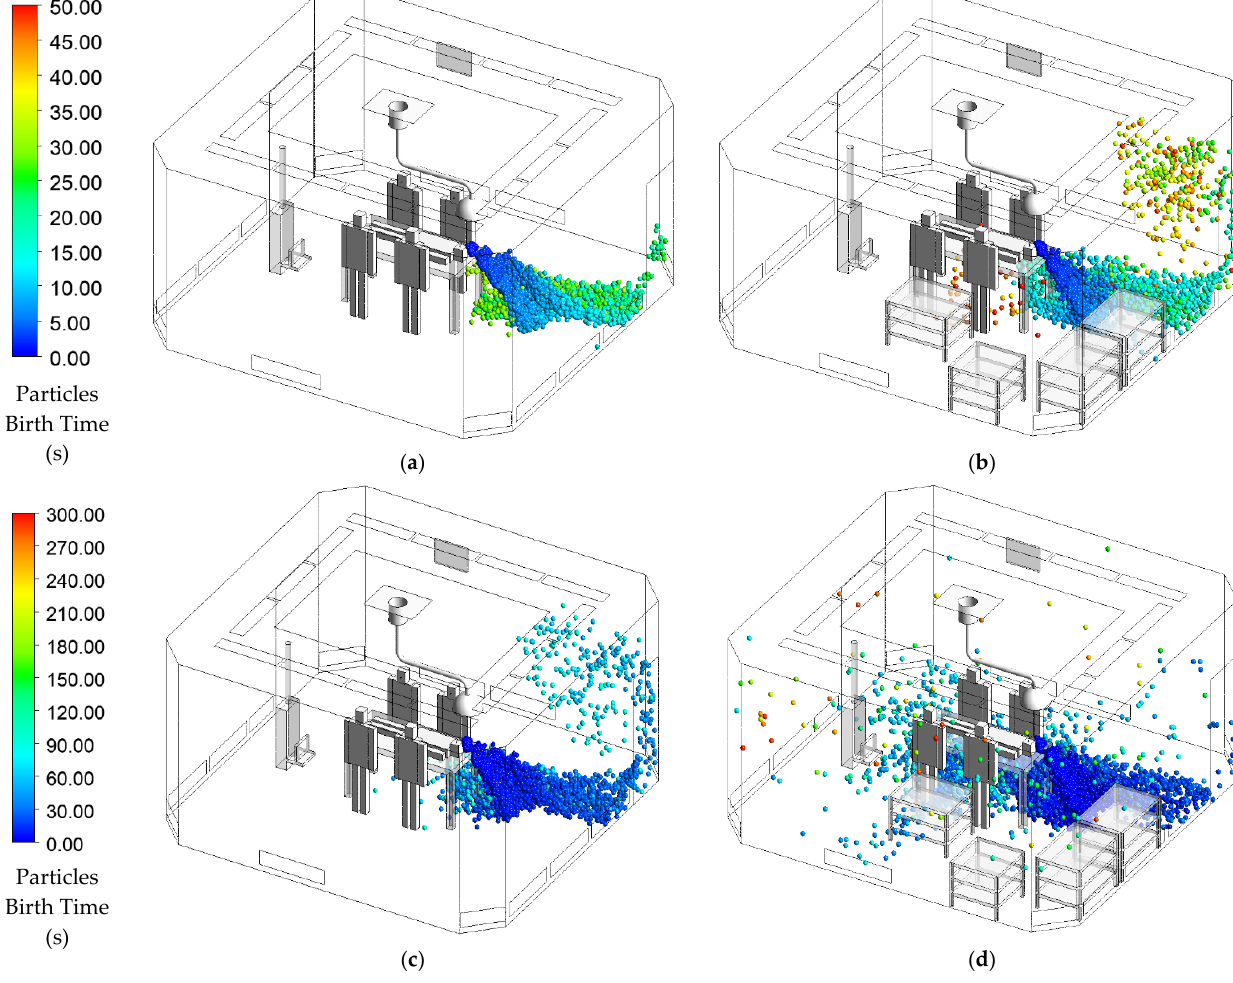
Figure 9. Distribution of bioaerosol particles in the operating room. ( a ) case 2: particle birth at 50 s; ( b ) case 3: particle birth at 50 s; ( c ) case 2: particle birth at 300 s; ( d ) particle birth at 300 s.